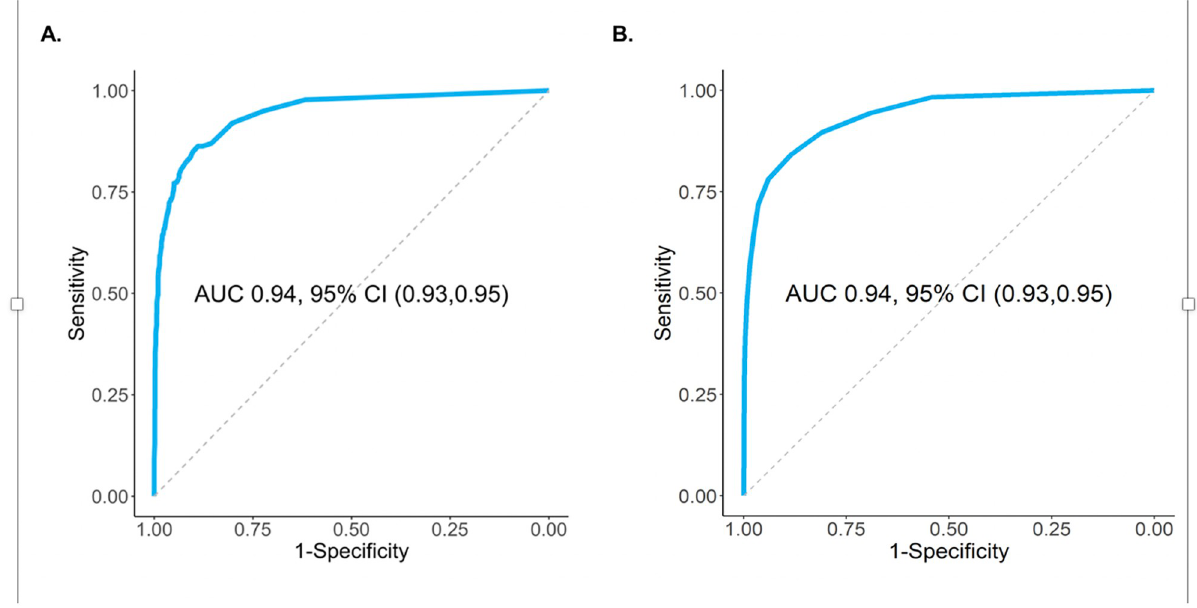
Fig 2. Receiver Operating Characteristics (ROC) Curves of mortality predicted by the machine learning XGBoost model and the clinical prediction model based on total point score in the test set of data. A. ROC for In-hospital Mortality Predicted by the Machine Learning XGBoost Model. B. ROC Curve for the Clinical Prediction Model Point